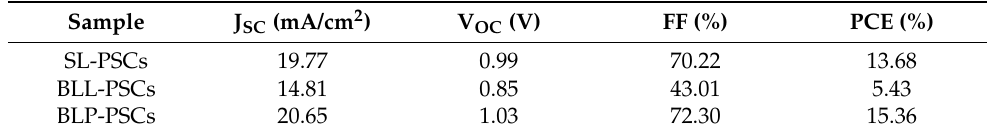
Figure 5. Nyquist plots of SL-PSCs, BLL-PSCs, and BLP-PSCs.